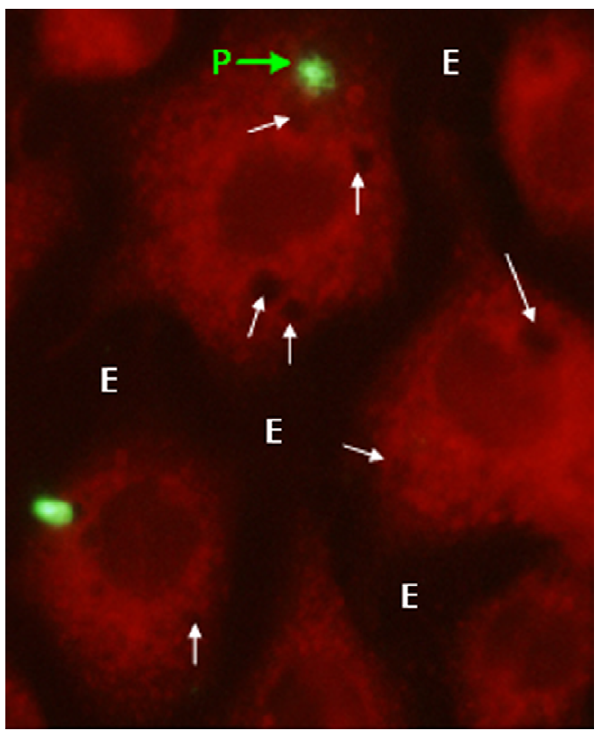
HepG2-A16 cells with high concentrations of primaquine (10 m g/mL) induced hepatotoxic changes. P : Parasite; White arrows : Dense bodies in cytoplasm; E : Empty spaces due to focal cell loss in the cell culture well.